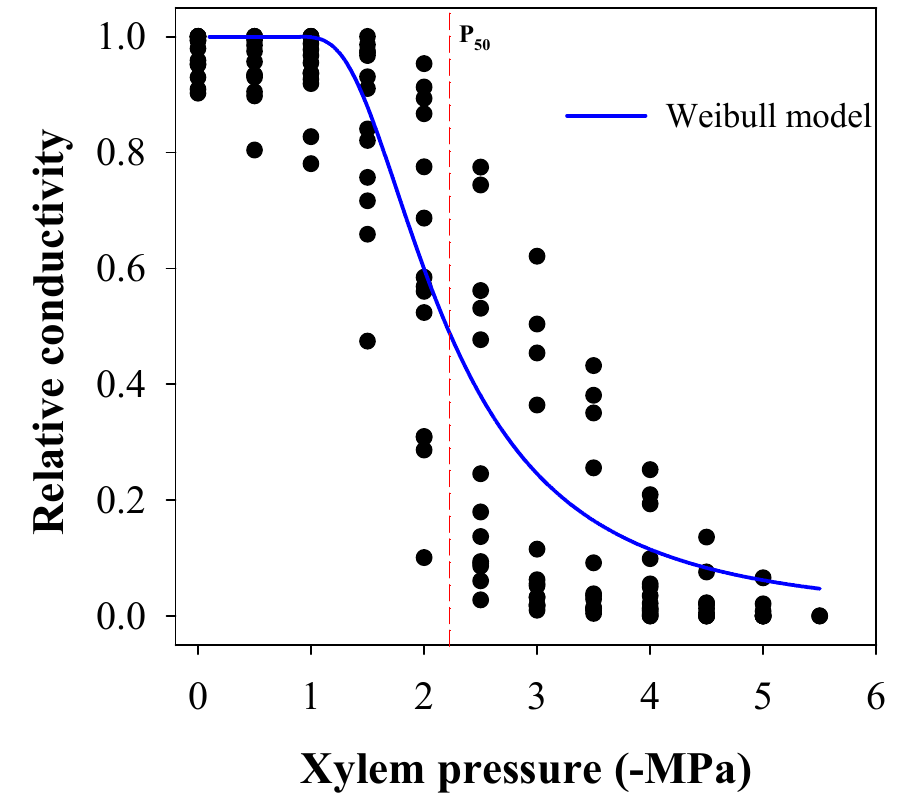
Figure 1. Relative loss of hydraulic conductivity for 2-year-old maqui plants ( Aristotelia chilensis (Molina) Stuntz).